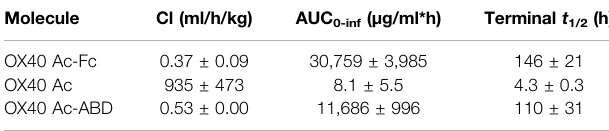
TABLE 4 | Pharmacokinetic parameters of Anticalin proteins in hSA/hFcRn mice (n (cid:2) 3, mean ±